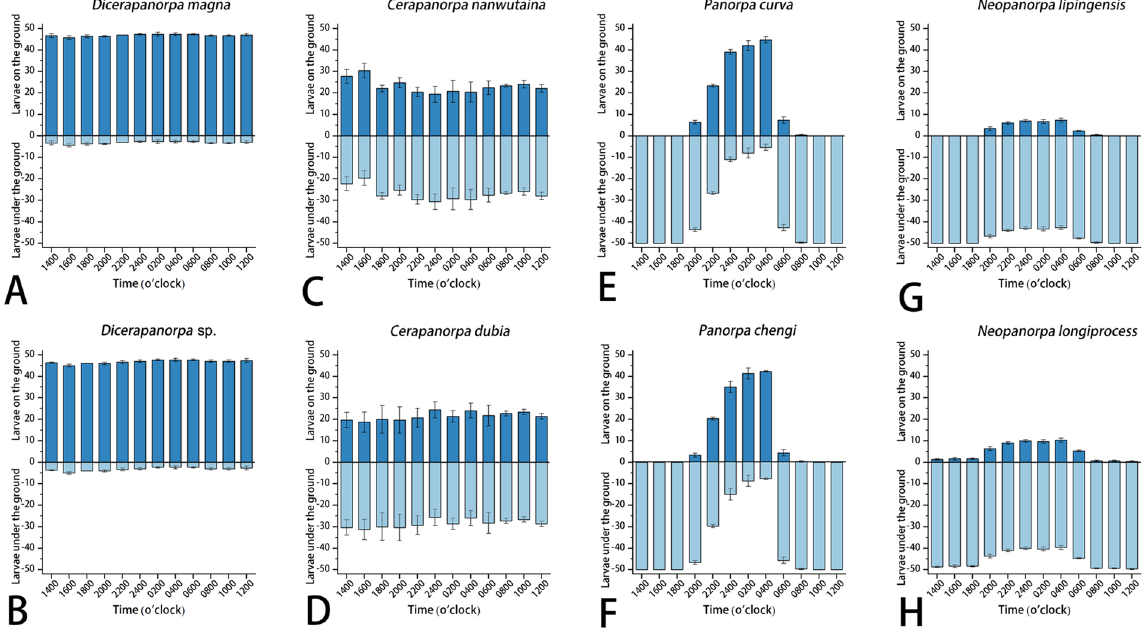
Figure 5. The number of larvae on/under the ground every two hours in a day (Mean ± SEM, n = 3), showing the circadian rhythm of larvae. ( A ) Dicerapanorpa magna ; ( B ) Dicerapanorpa sp.; ( C ) Cerapanorpa nanwutaina ; ( D ) Cerapanorpa dubia ; ( E ) Panorpa curva ; ( F ) Panorpa chengi ; ( G ) Neopanorpa lipingensis ; ( H ) Neopanorpa longiprocessa .